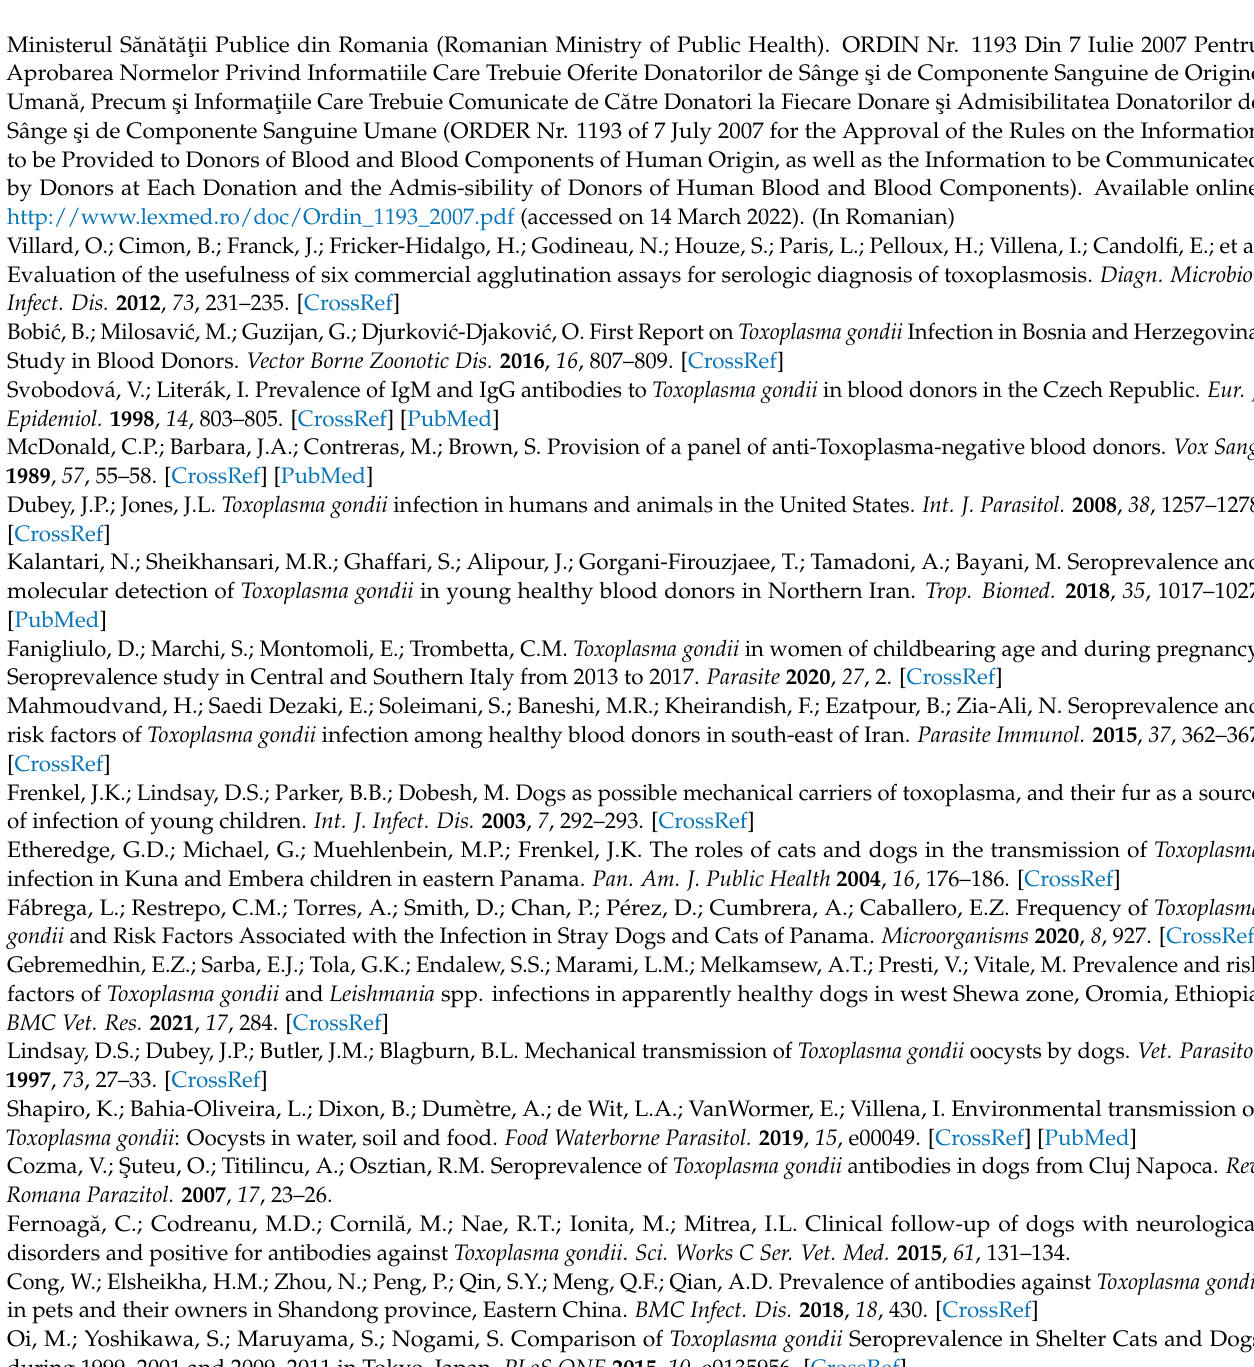
Ministerul S ă n ă t ă ¸tii Publice din Romania (Romanian Ministry of Public Health). ORDIN Nr. 1193 Din 7 Iulie 2007